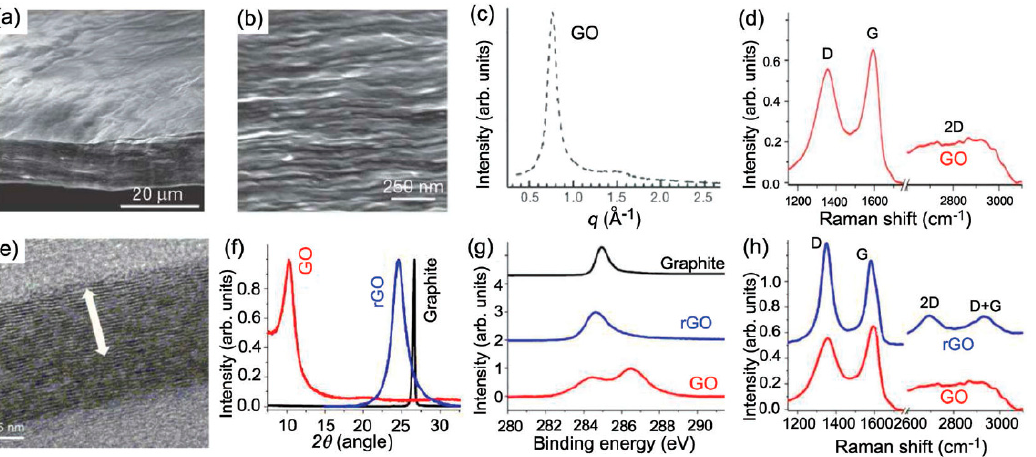
Figure 1. ( a ) Low- and ( b ) high-resolution SEM side-view images of a 10 mm-thick GO paper. ( c ) X-ray diffraction pattern of the GO paper sample. ( d ) Raman spectrum of a typical GO paper. ( e ) Cross-section TEM images of a stack of rGO platelets. ( f ) Powder XRD patterns of graphite, GO, and rGO. ( g ) XPS characterization of rGO platelets. ( h ) Raman spectra of rGO (blue) and the GO reference sample (red). Reproduced from [13].